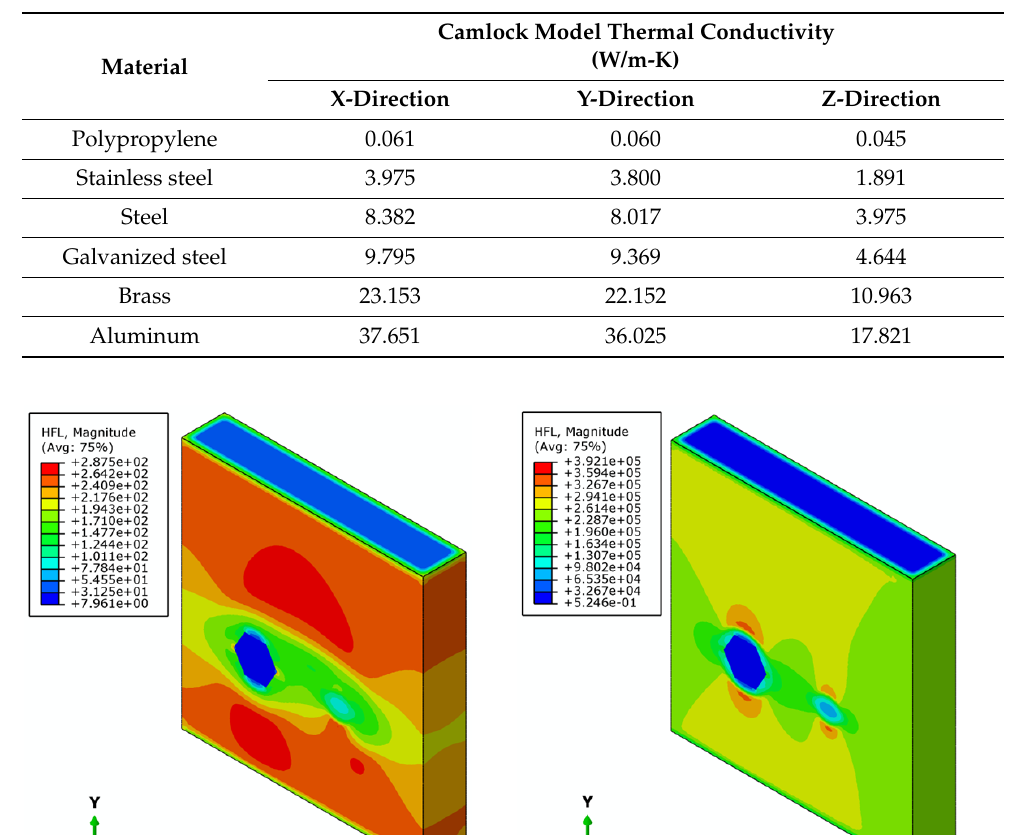
Table 2. Orthotropic thermal conductivities derived from the camlock model.